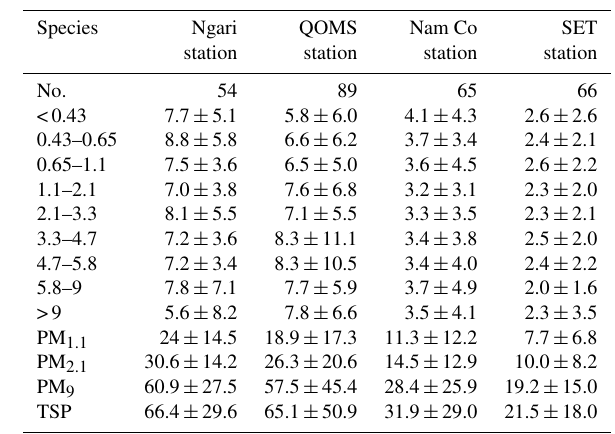
Table 3. Average mass concentrations ± standard deviations (µgm − 3 ) for size-segregated particles (at various µm) and PM 1 . 1 , PM 2 . 1 , PM 9 and TSP sampled from the HTP surface atmosphere during 2011–2013. No. stands for number of samples.